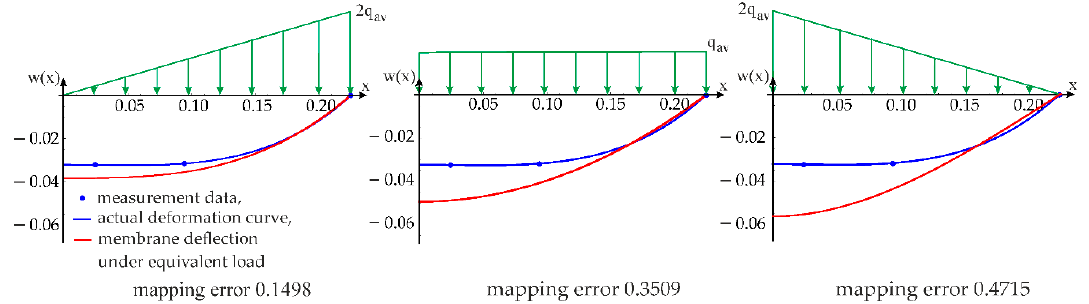
Figure 4. Comparison of the deflection curve of the reinforcement with the deflection curve of the membrane for three equivalent load distributions (inverse triangular, uniform and triangular), using Formula (2); (source of measurement data [10]).